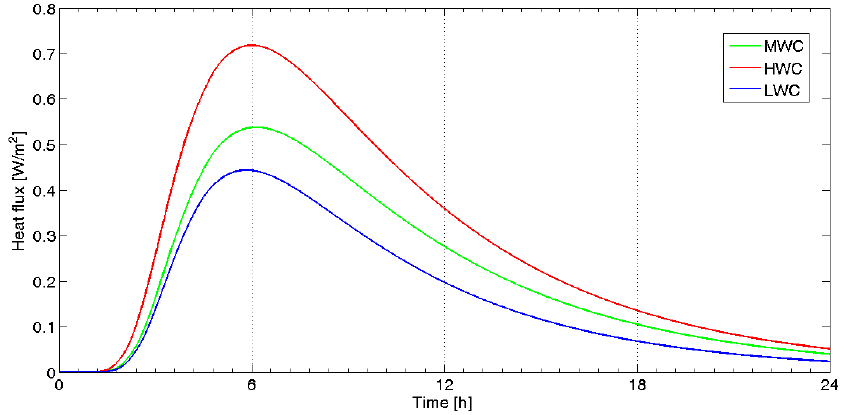
Figure 5. Heat flux vs. time for blocks filled with Mineral Wool and different clay densities. Comparing time evolution of heat flux for blocks made of the same clay (HWC) but with different infill materials, larger differences in time lag were found, as shown in Figure 6. What is more evident is that although the full block has the highest front mass, it shows the least time lag.